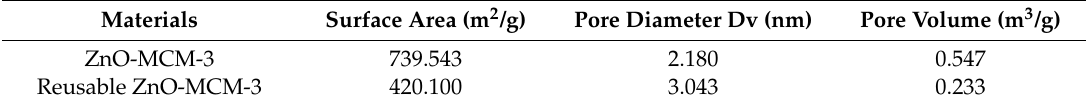
Table 5. The pore structural parameters of ZnO-MCM-3 after six photodegradation cycles of MO.